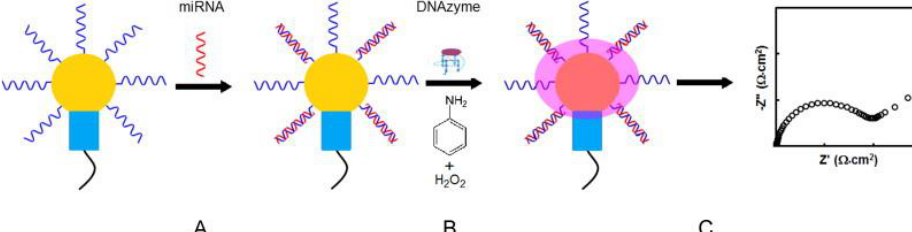
Scheme 6. Schematic illustration of the working principle of the label-free miRNA biosensor: ( A ) miRNA hybridization, ( B ) hybridized miRNA-guided PAn deposition, and ( C ) Nyquist plot. Reprinted with permission from [36]. Copyright (2014) Elsevier.